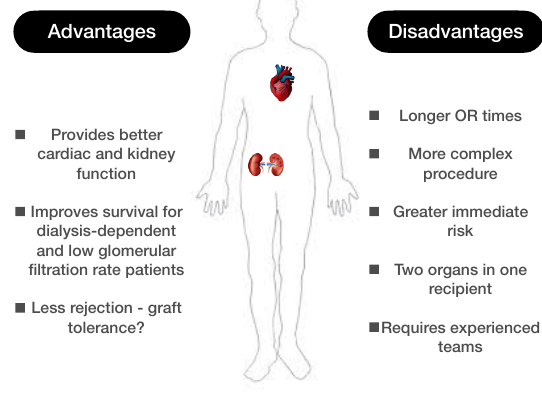
Fig. 1 - Combined heart and kidney transplantation: advantages and disadvantages. OR=operating